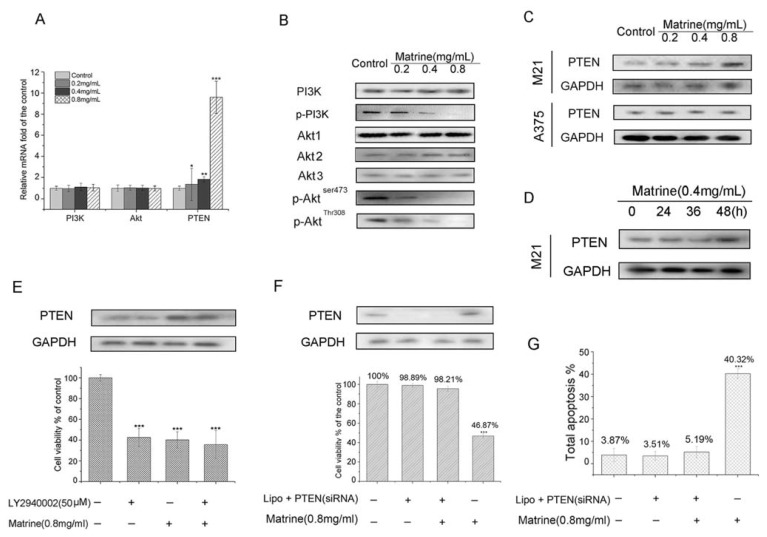
(A) Relative mRNA level of PI3K, Akt and PTEN in Matrine treated M21cells. Cells were incubated with Matrine at concentration as indicated for 48 h before performing real-time PCR; (B) Protein expression of PI3K, the phosphorylation form of PI3K (p-PI3K), Akt 1, Akt 2 and the phosphorylation form of Akt (p-Aktser473) in M21 cells with Matrine treatment; (C) Protein expression of PTEN in M21 cells and A375 cells with Matrine treatment. Cells were incubated with Matrine at concentration as indicated for 48 h before performing Western blotting; (D) Protein expression of PTEN in M21 cells with Matrine treatment at the time point as indicated; (E) The anti-proliferative activity of Matrine and LY2940002 or combination in M21cells; (F) Growth inhibition blocks in PTEN silencing or not M21 cells with Matrine; (G) Total apoptosis percentage induction inhibition blocks in M21 cells. All data were expressed as means ± SD of three separate experiments. Significant differences from untreated control were indicated as *p < 0.05; **p < 0.01; ***p < 0.001.